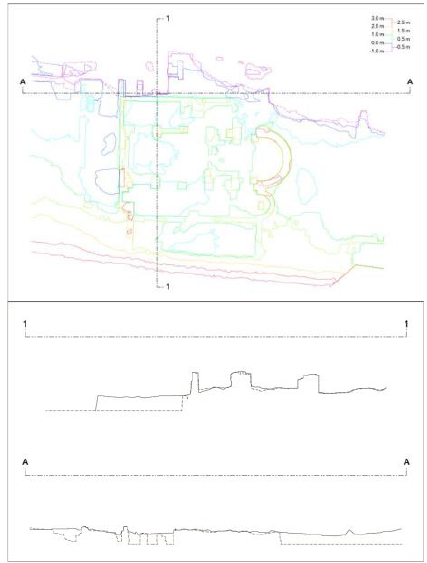
Figure 5: Stratified Plan of the San Clemente area in 2017 (top) and two cross sections